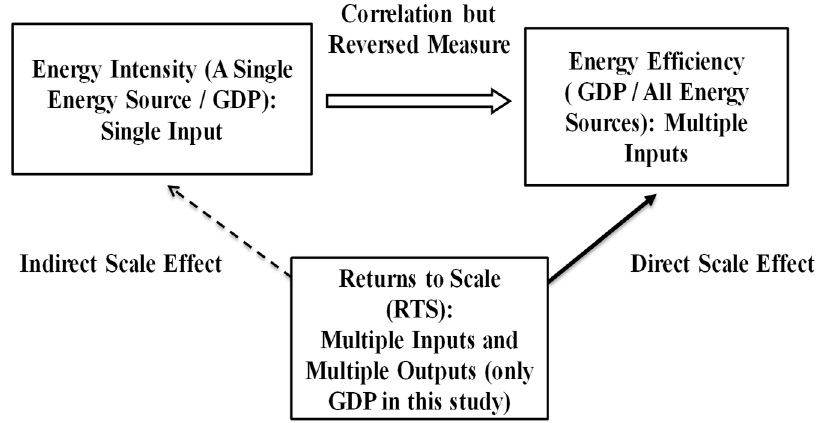
Figure 3. Relationship among EI, EE, and RTS. Note: (a) The authors have prepared the figure for this research. The “energy intensity (EI)” is measured as a single energy consumption divided by GDP. Conversely, the “energy efficiency (EE)”, corresponding to operational efficiency ( OE ) in DEA, is measured by GDP divided by the consumption of all energy sources. The “returns of scale (RTS)” are measured by a change of GDP divided by a unit change of all energy source consumptions. (b) GDP is an output in this study. The type of RTS is measured for the single output (GDP). The DEA/RTS may handle a general case of